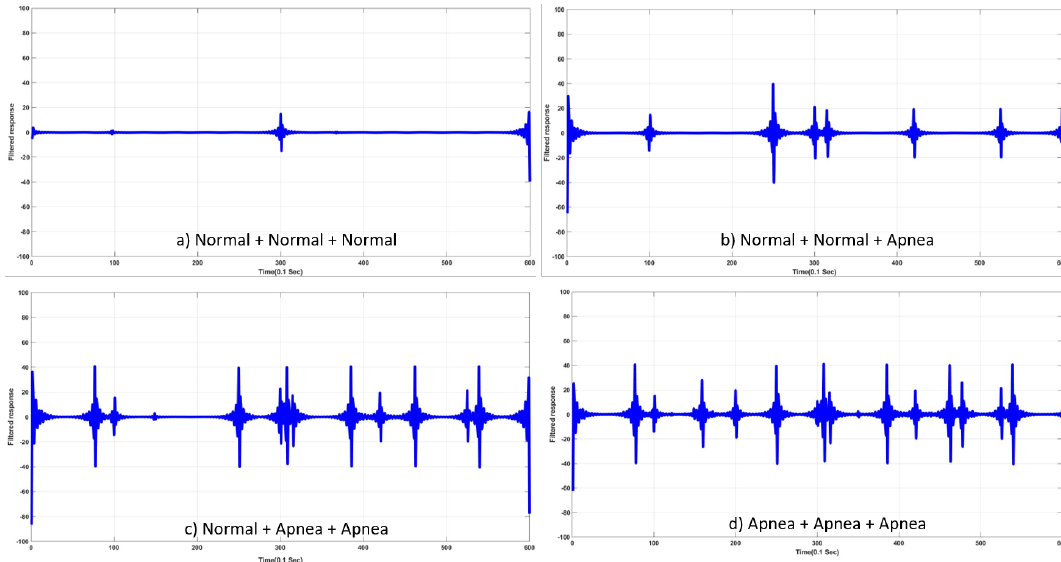
Figure 13. Examples of outputs that were filtered responses by varying cut-off frequency of